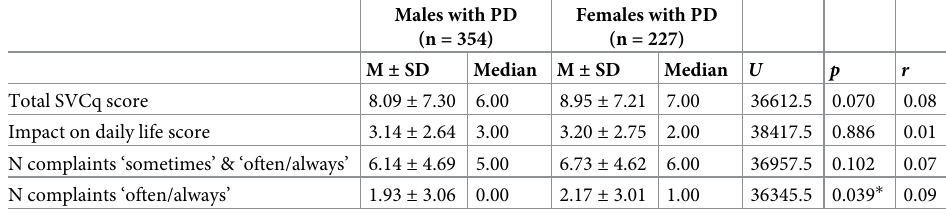
Table 7. SVCq scores of male and female individuals with PD, with Mann-Whitney U test results.